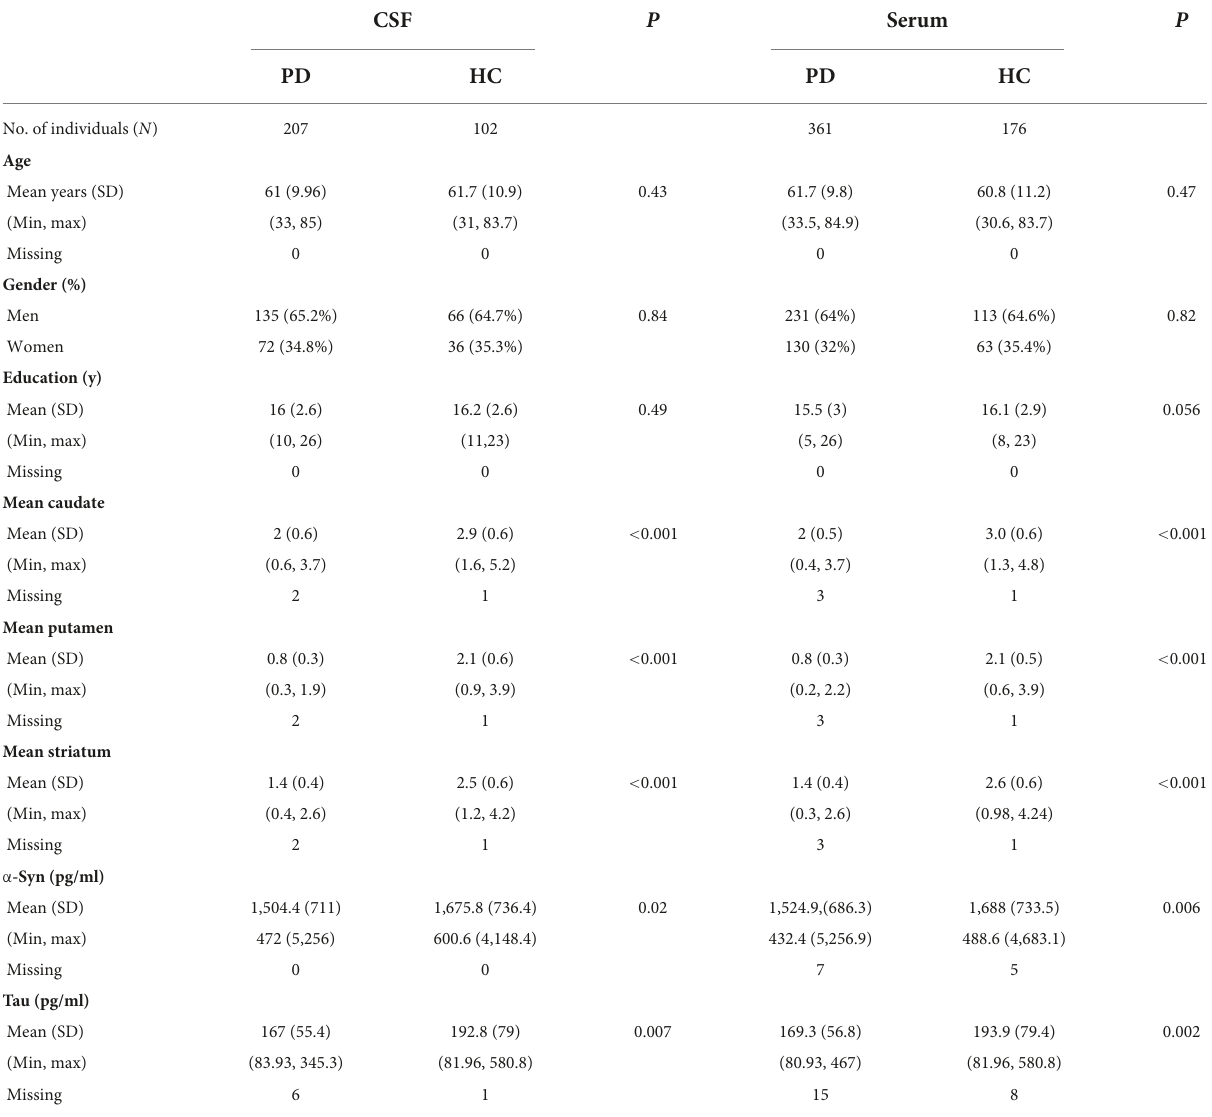
TABLE 1 Baseline demographics and clinical